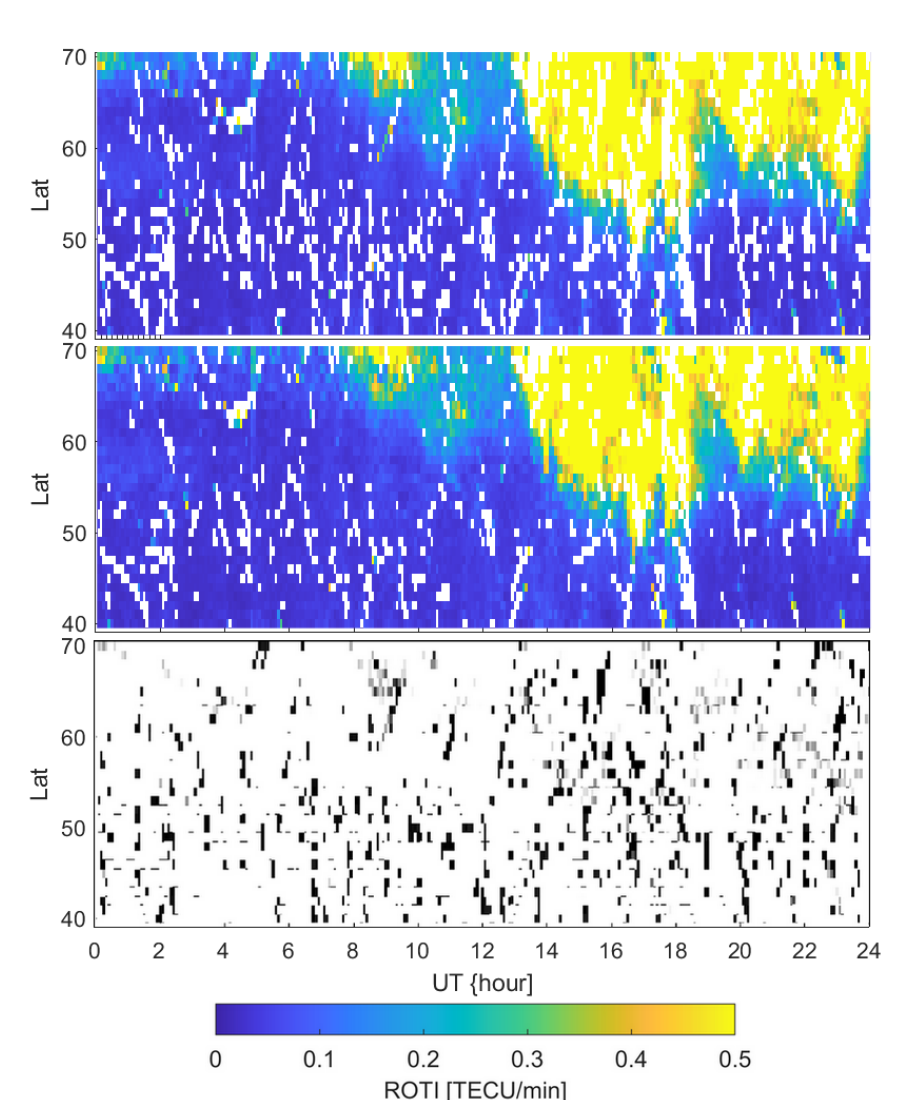
Figure 10. Comparison between ROTI obtained with only 23 stations broadcasting real-time streams (top panel) and all 40 selected stations (middle panel) for a day of the storm (case of 17 March 2015). The bottom panel presents residuals with black pixels indicating extra blank spots in the solution based only on the stations providing real-time data